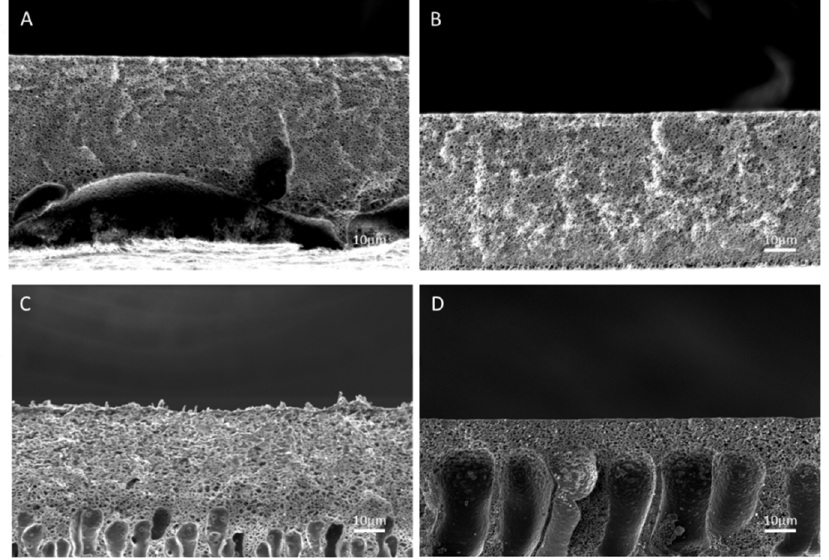
Figure 10. Cross section of membranes with solvent/co-solvent (NMP/IPA) ratios in the solvent mixture of ( A ) 100/0, ( B ) 90/10, ( C ) 80/20, ( D ) 70/30.